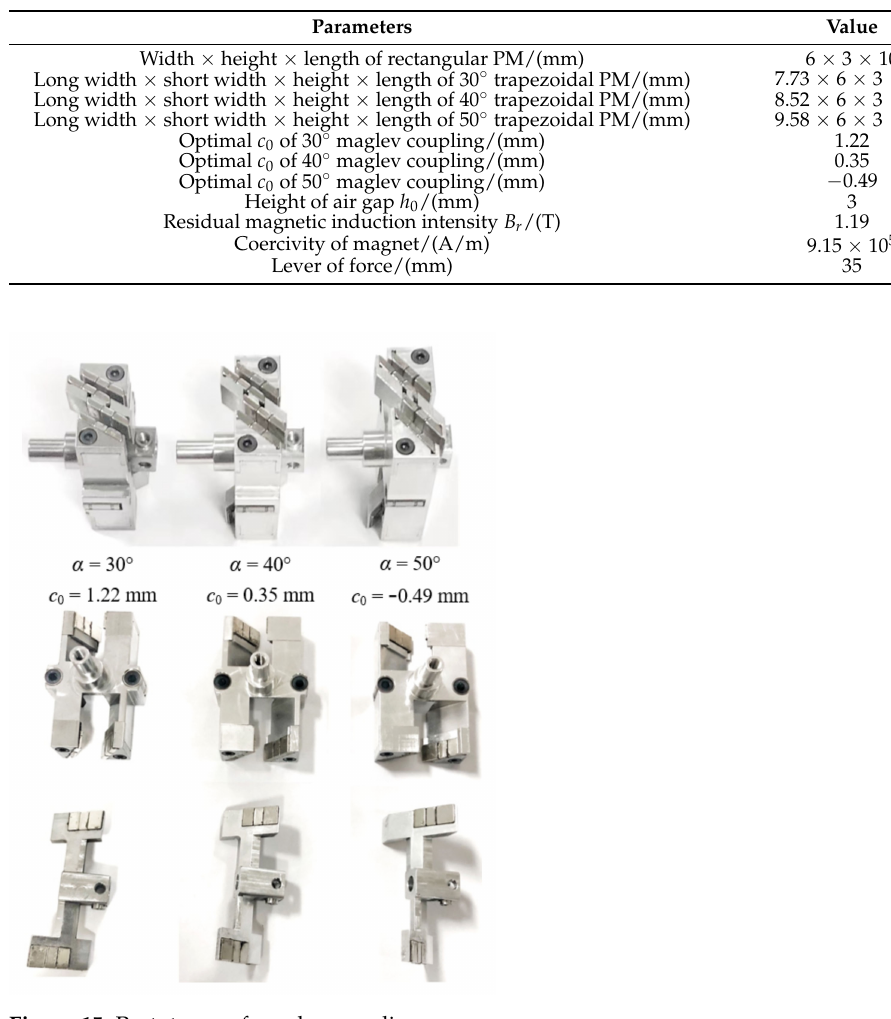
Figure 15. Prototypes of maglev